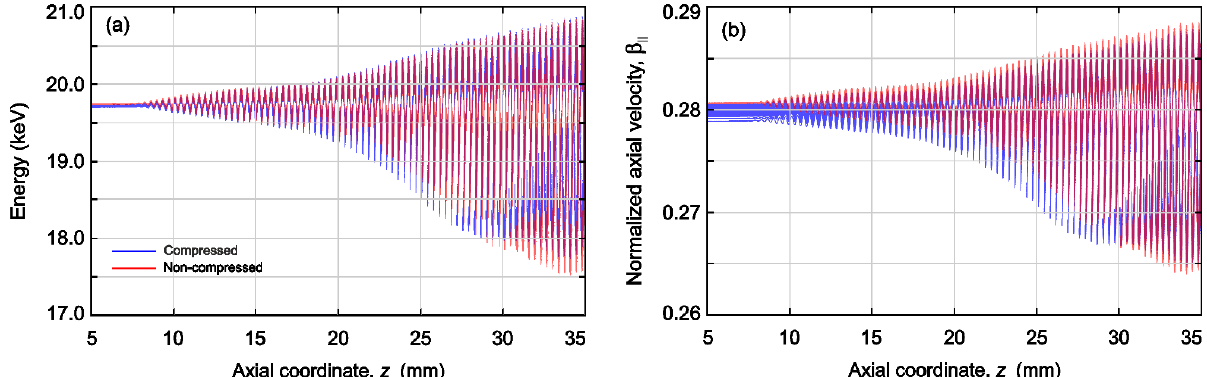
Figure 10. Phase diagrams of the compressed (blue) and non-compressed (red) beams at 19.75 kV voltage, 0.22 THz frequency, and 1.0 W input power. ( a ) Energies and ( b ) axial velocities versus axial coordinate z.